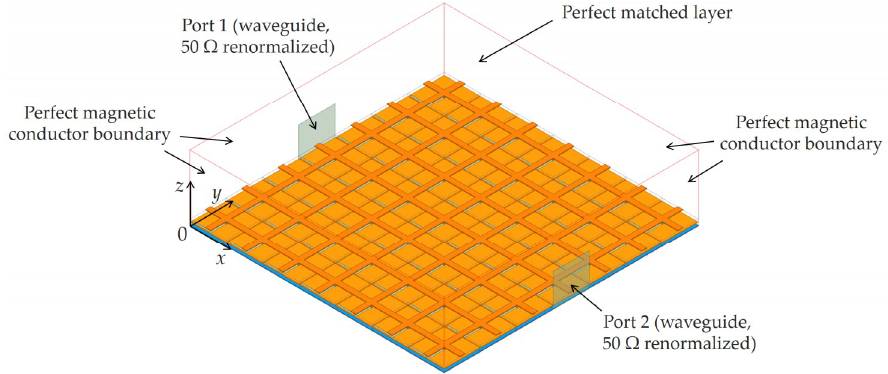
Figure 9. Finite di ff erence method (FEM)-based simulation model of the DP–EBG structure with a Figure 9. Finite difference method (FEM)-based simulation model of the DP–EBG structure with a 7×7 7 × 7 array.